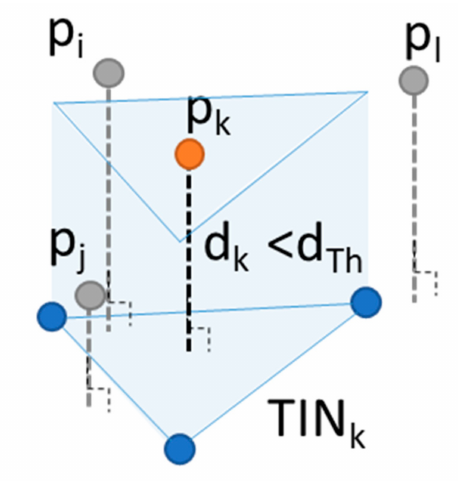
Figure 7. Criteria for adding new